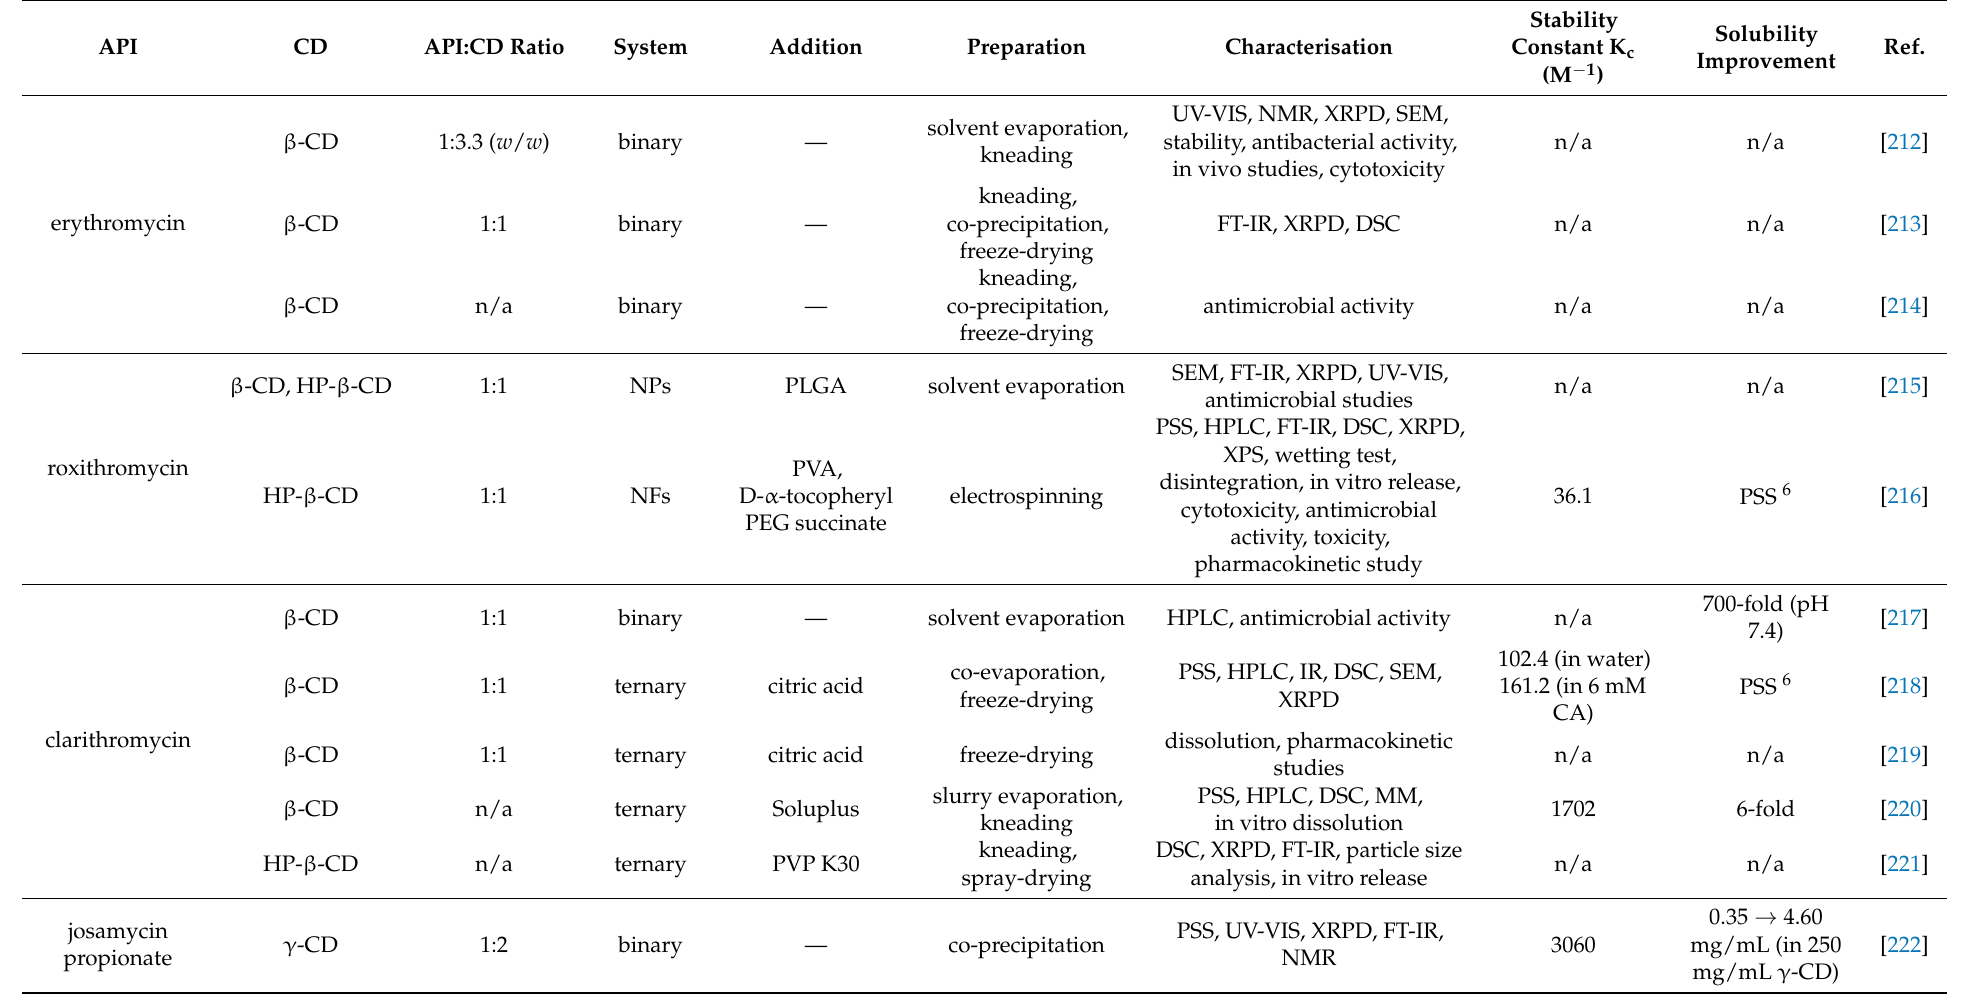
Table 7. Detailed information of macrolides complexes on the types of CDs used, methods of complex preparation, and techniques used to characterise the obtained products